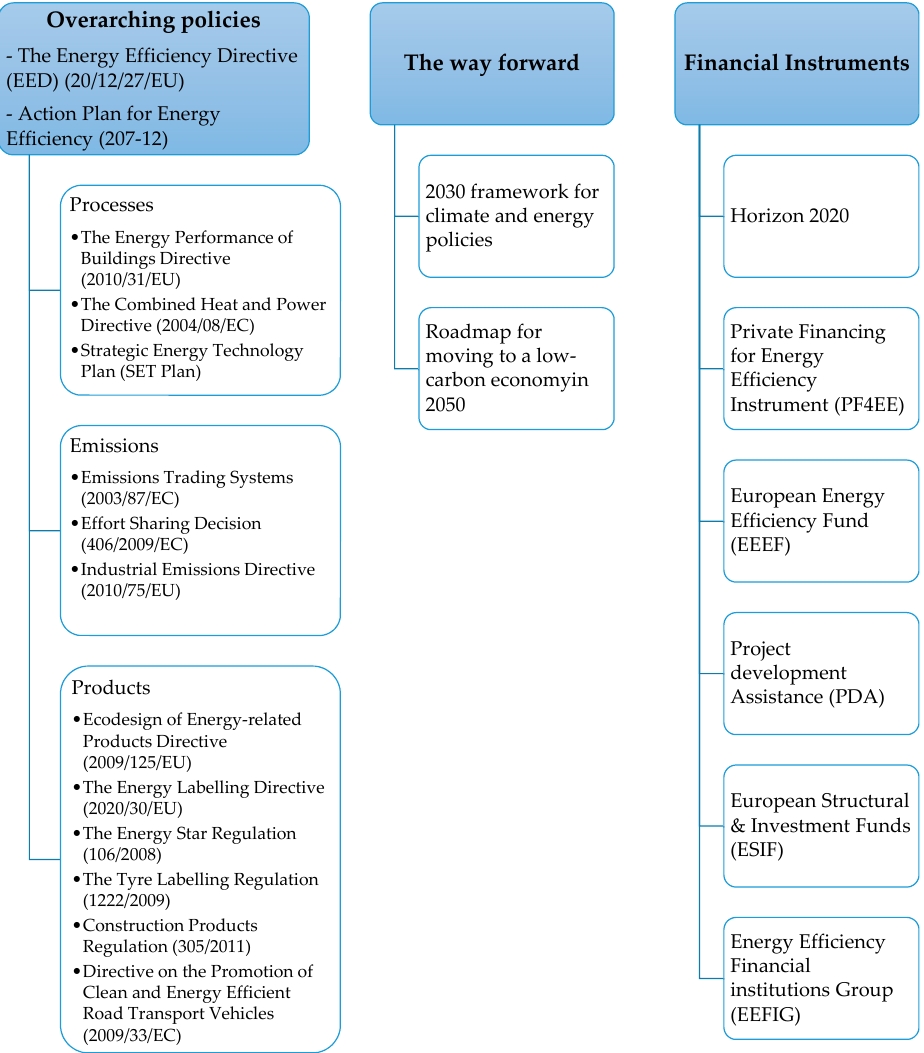
Figure 1. Legal Energy Efficiency framework in the EU [4].